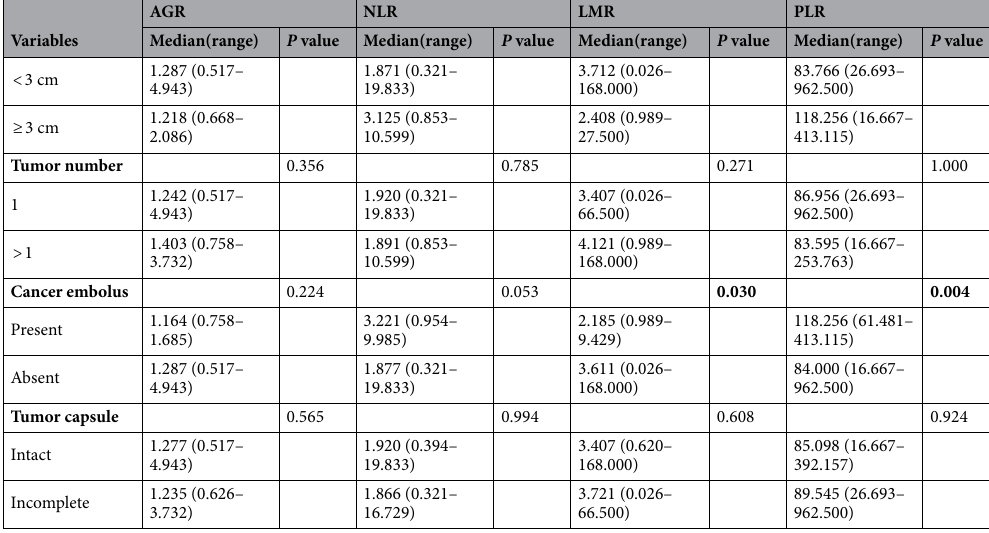
Table 2. Associations of inflammation-based markers with clinicopathologic characteristics in training cohort. P value of less than 0.050 was considered to indicate significant difference. The P value was calculated by nonparametric Wilcoxon rank-sum test. AFP alpha-fetoprotein, HBV hepatitis B virus, HCV hepatitis C virus, AGR albumin to globulin ratio, NLR neutrophil to lymphocyte ratio, PLR platelet to lymphocyte ratio, LMR lymphocyte to monocyte